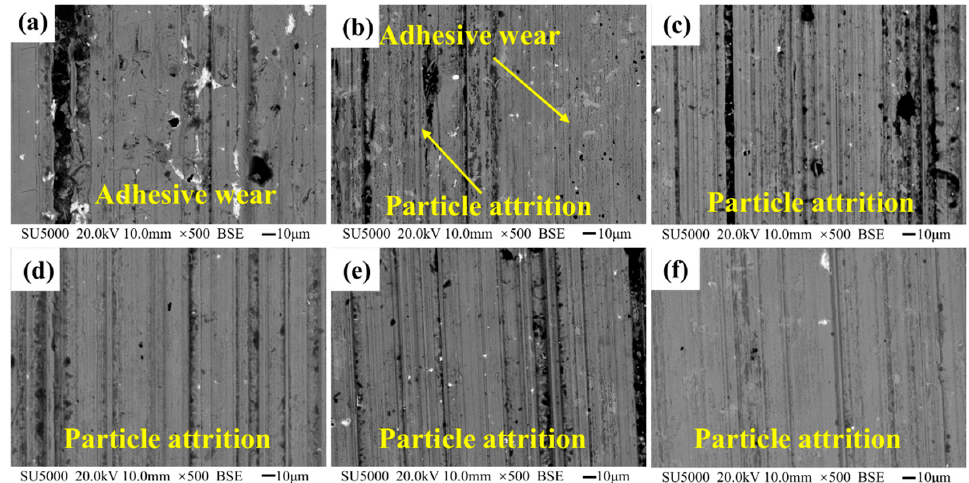
Figure 9. The copper layer wear scar morphology. ( a ) 400 °C, ( b ) 500 °C, ( c ) 600 °C, ( d ) 700 °C, ( e ) 800 °C, and ( f ) 900 °C.